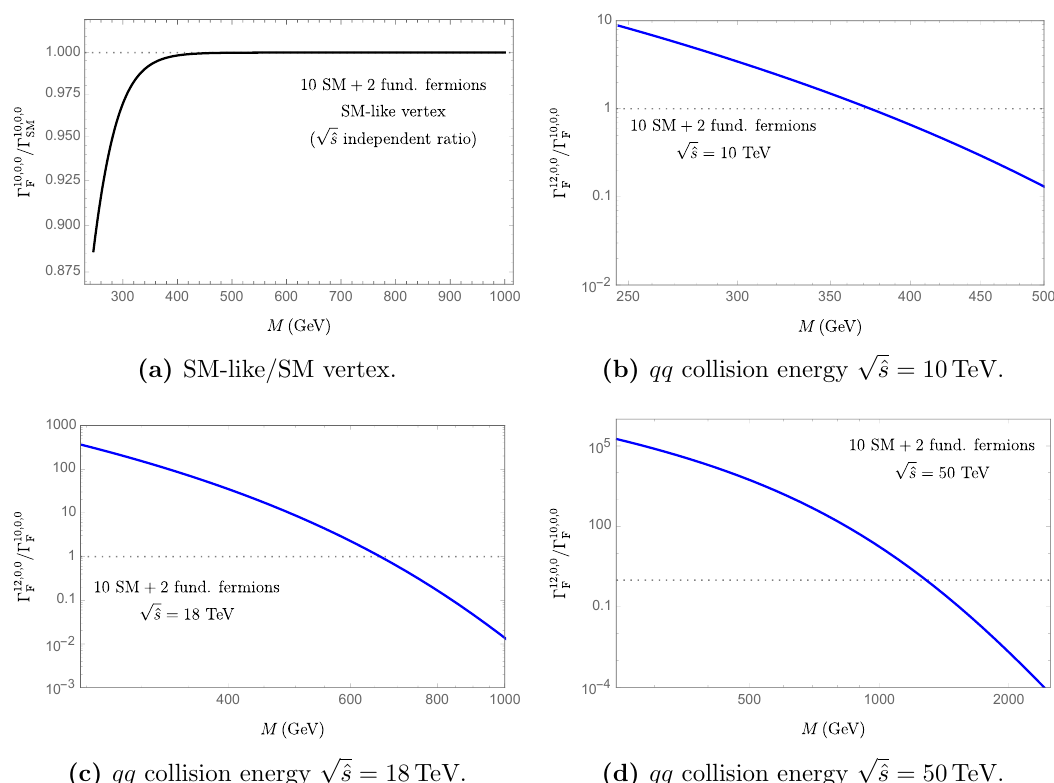
Figure 1. SM-like/SM (upper left) and BSM/SM-like rate ratios for two additional heavy mass fermions in the fundamental representation of